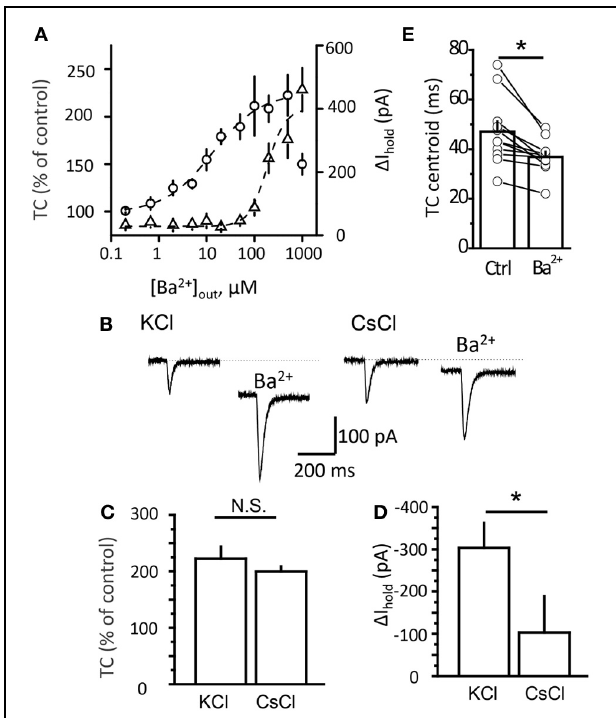
FIGURE 3 | Potentiation of transporter current is independent of K ir blockade. (A) Dose-response curve of TC (circles) and (cid:3) I hold (triangles) changes. (B) Transporter current (TC) elicited by local glutamate uncaging in control and in 200 µ M Ba 2 + . The downward shift in the holding current was less pronounced in Cs + -loaded cells (CsCl). The TC amplitude increased to a similar degree in both cases. (C,D) Mean Ba 2 + effect on transporter current (TC, B ) and I hold ( (cid:3) I hold , C ) for CsCl- and KCl-based intracellular solutions. (E) Transporter current centroids in control and in 20 µ M Ba 2 + . Error bars—SEM. ∗ P < 0 . 05; N.S.—non significant; paired (E) and unpaired (C,D ) t